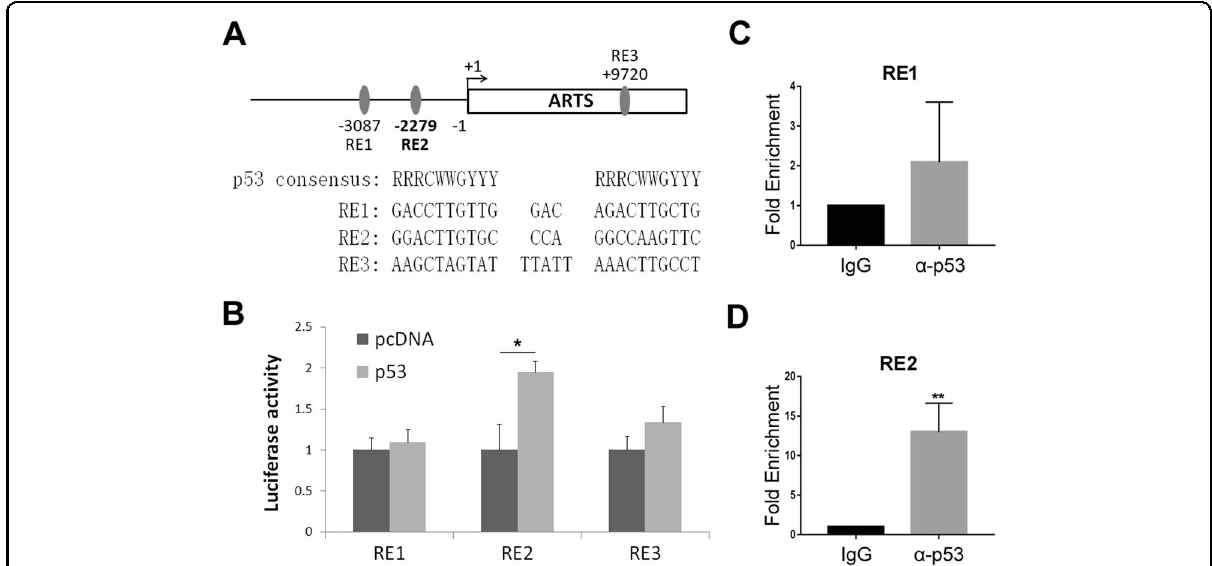
Fig. 3 p53 associates and activates ARTS promoter. A A schematic of the predicted p53-responsive elements on the promoter or within the intron of ARTS. B p53 induces the expression of a luciferase reporter gene driven by RE1. H1299 cells were transfected with plasmids as indicated in the “ Materials and methods ” for over 30 h followed by the luciferase assay. C , D p53 associates with RE2, but not RE1, on the ARTS promoter. HCT116 p53 + / + cells were prepared for the ChIP-qPCR analysis using the antibodies as